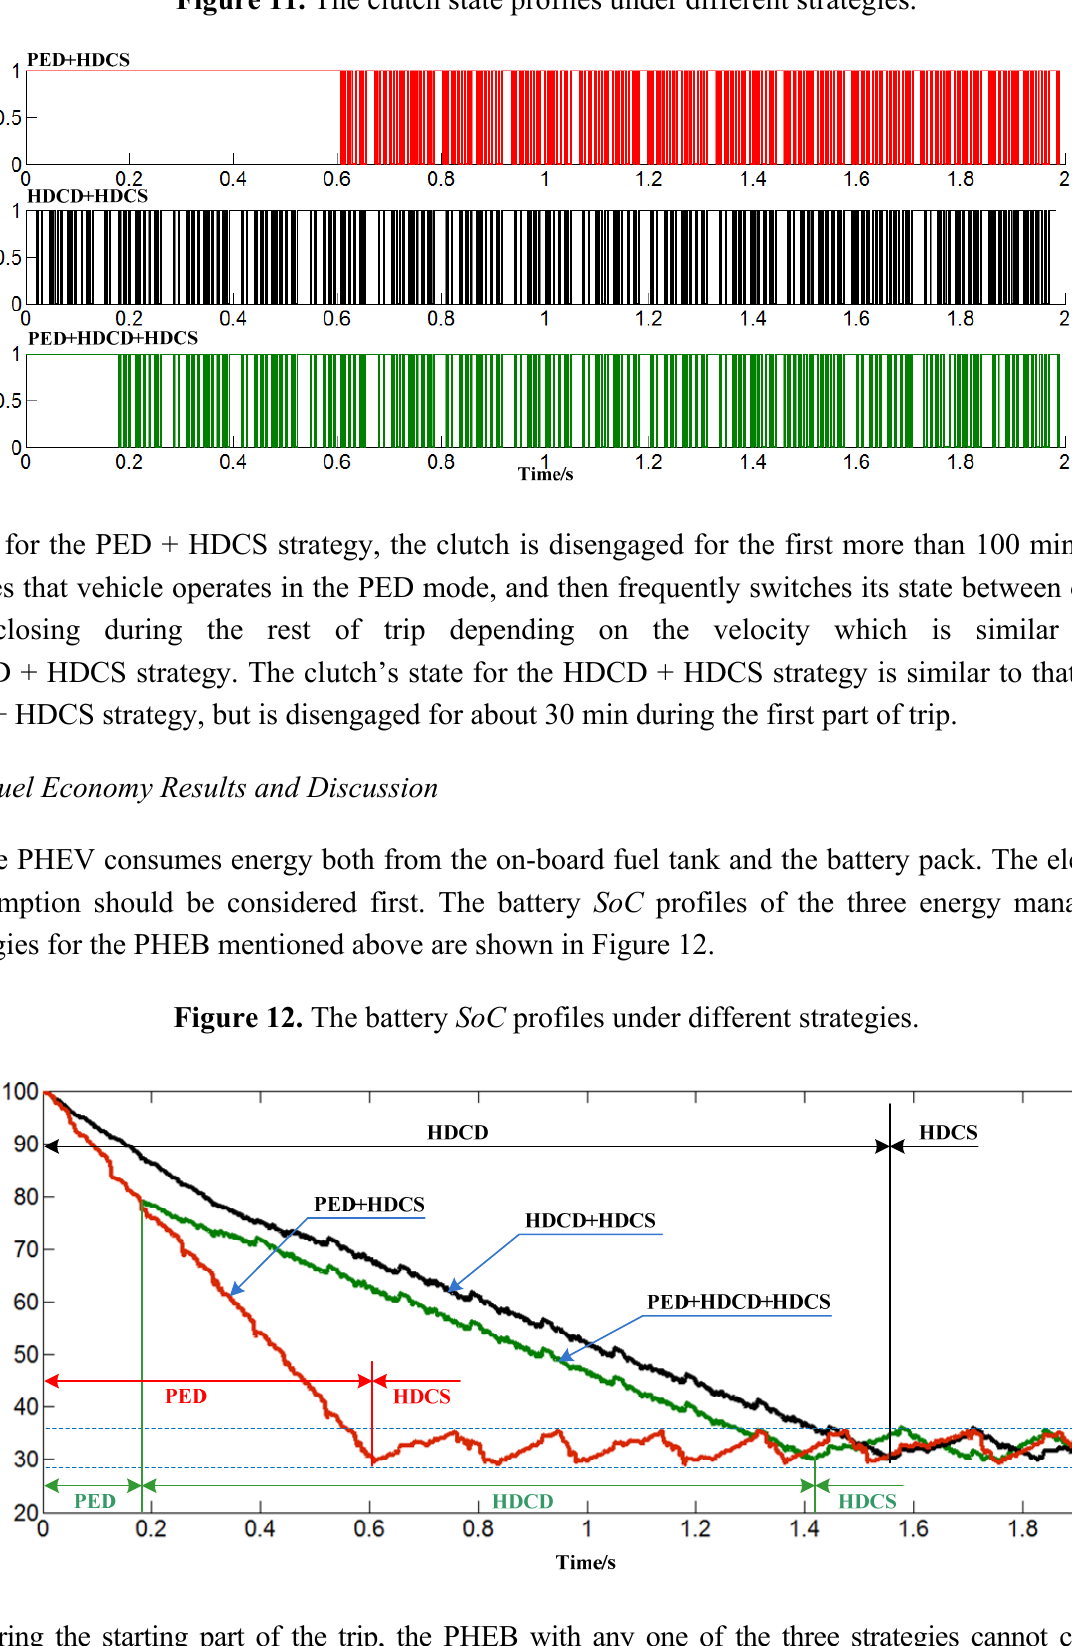
Figure 11. The clutch state profiles under different strategies.